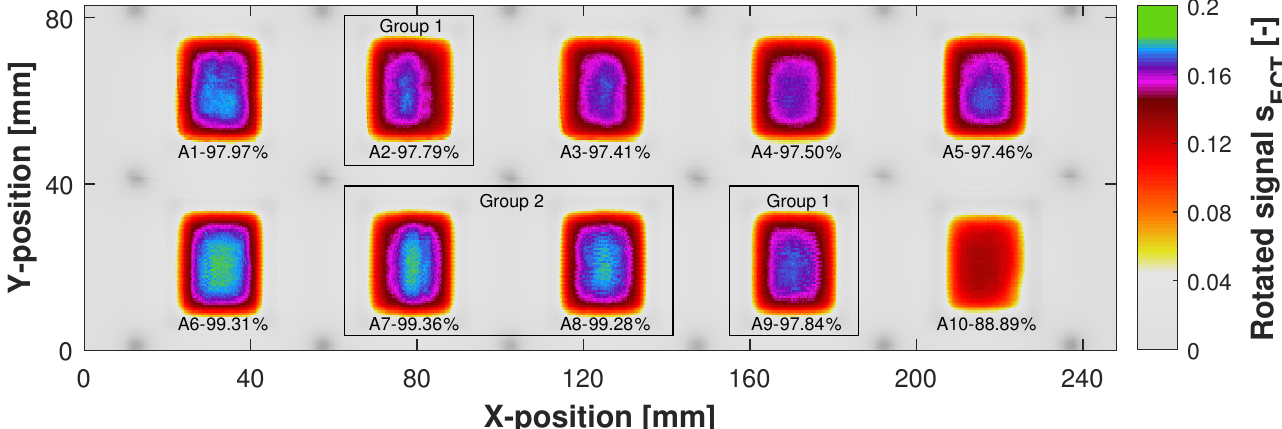
Figure 5. Image obtained from the 2D scan of the AlSi10Mg parts. The data contain the rotated signal mapped to the X and Y position of the sensor during the raster scan as described in Section 2.3. Below each part, the part description and relative density are presented. Non-significant differences between mean rotated signals of samples are indicated by grouping the respective parts. Table 4. Results of the pairwise multiple comparisons via the Games–Howell post hoc test based on Welch’s analysis of variance ( F ( 9, 845 ) = 18760, p < 0.01). The samples with sample size n = 209 were obtained from a 2 × 5-mm 2 (X × Y) region in the center of each of the 10 parts (AlSi10Mg). ** p < 0.01, * p < 0.05, ns not